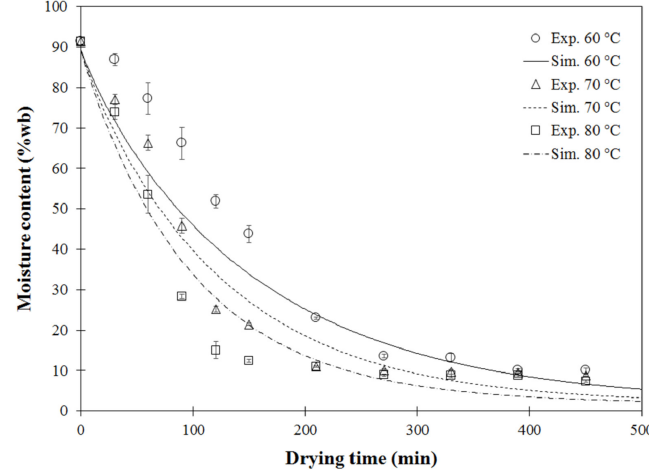
Figure 1. Comparison of experimental and model-predicted moisture content at different drying temperatures: Exp (experimental result), Sim (simulated result).